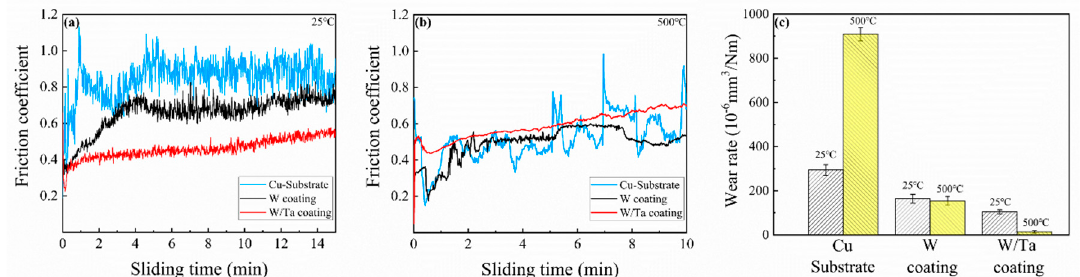
Figure 7. The tribological properties of the substrate and coating specimens: ( a ) the coefficients of friction (CoFs) at 25 °C, ( b ) the CoFs at 500 °C, and ( c ) wear rates of specimens at 25 and 500 °C.